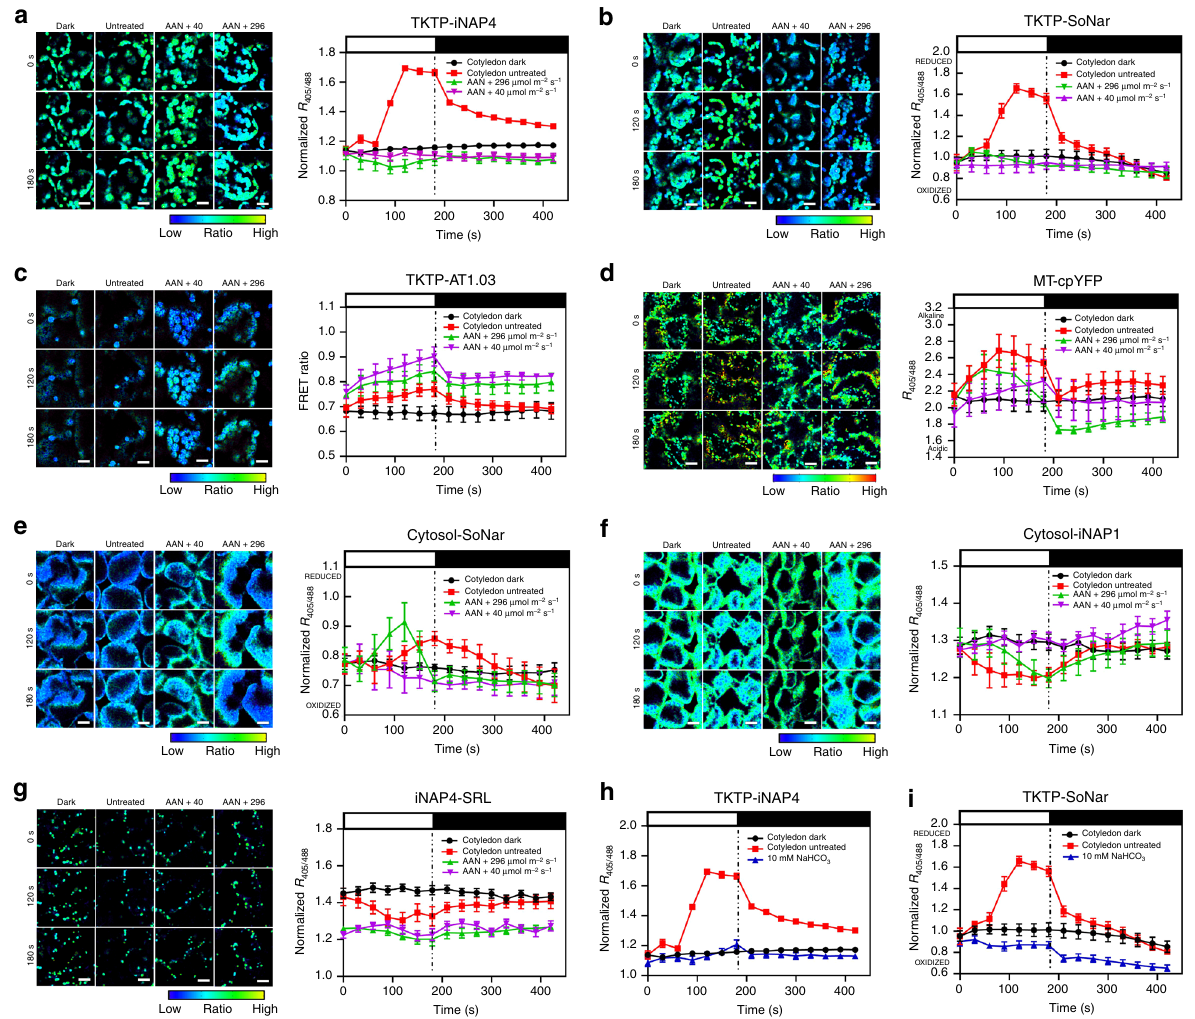
Fig. 3 Dynamic changes of NADPH level, NADH/NAD + ratio, MgATP 2- ratio, and pH level in 10-day-old seedlings pre-treated with aminoacetonitrile [AAN] or NaHCO 3 . The normalized ratiometric shifts of seedlings pre-treated with 18 mM AAN carrying a stromal iNAP4, b stromal SoNar, c stromal AT1.03, d mitochondrial matrix cpYFP, e cytosolic SoNar, f cytosolic iNAP1, and g peroxisomal iNAP4 in cotyledon in response to illumination for an interval of 30 – 180 s at 296 μ mol m − 2 s − 1 , or 40 μ mol m − 2 s − 1 , are shown. The normalized ratiometric shifts of seedlings in in half-strength Murashige and Skoog medium containing 10 mM NaHCO 3 carrying h stromal iNAP4, i stromal SoNar and illuminated at 296 μ mol m − 2 s − 1 are also shown. The illumination period is indicated by white bars and the values under the black bars represent data obtained after light withdrawal at 180 s ( n = 5; error bars ± SEM). Scale bars, 20 µ m. All iNAP and SoNar results presented were normalized with cytosol-iNAPc, TKTP-iNAPc, and iNAPc-SRL,